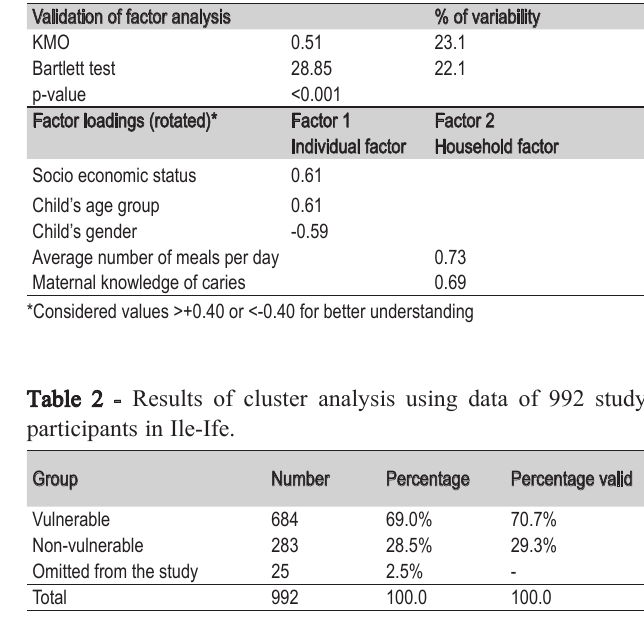
Table 1 - Results of factor analysis.